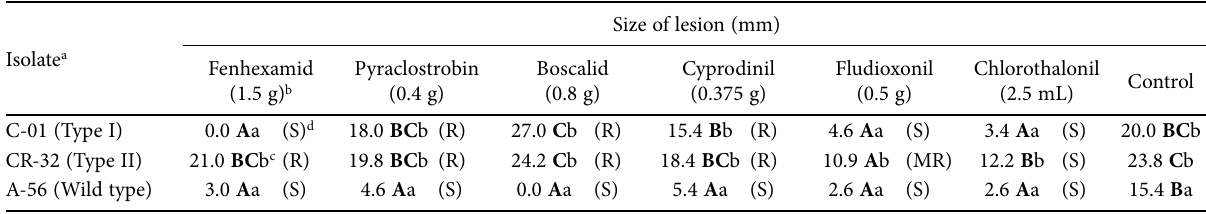
Table 3. In situ lesion development on lettuce leaves treated with fungicides and inoculated with multiple resistant isolates of Botrytis cinerea